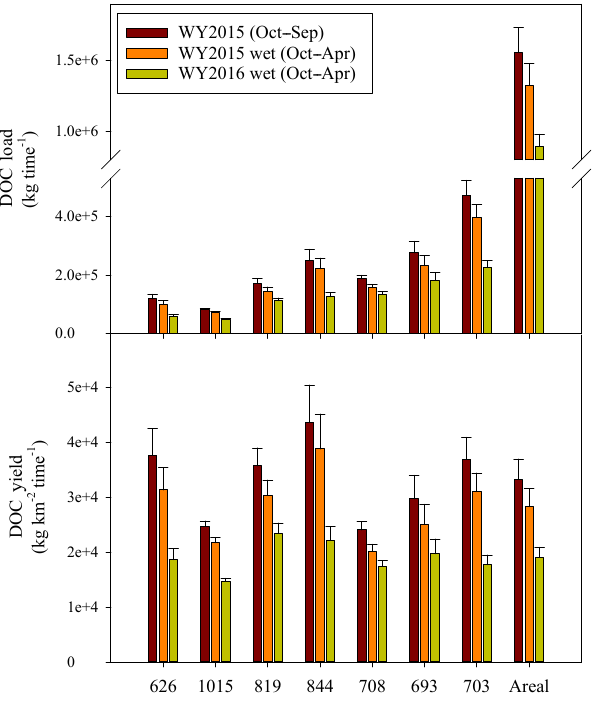
Figure 5. DOC fluxes and yields for the seven study watersheds and the total area of study (“areal”, all watersheds combined) on Calvert and Hecate islands for water year 2015 (WY2015; 1 October– 30 September), and 1 October–30 April of the wet period for water year 2015 (WY2015 wet) and water year 2016 (WY2016 wet). Be- cause DOC yields were only available for September in WY2015, this month was excluded from the wet-period totals in order to make similar comparisons between years. Error bars represent standard